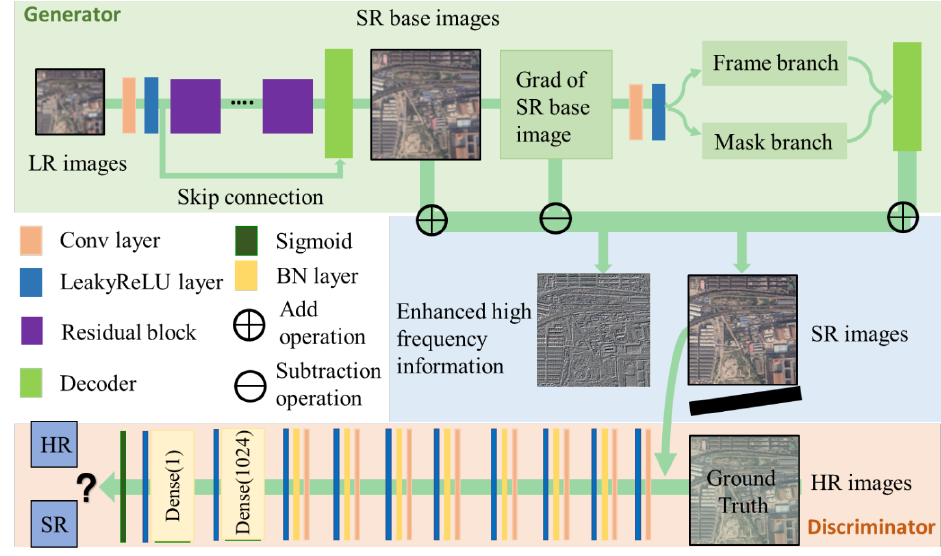
Figure 3. The architectures of the proposed EASR